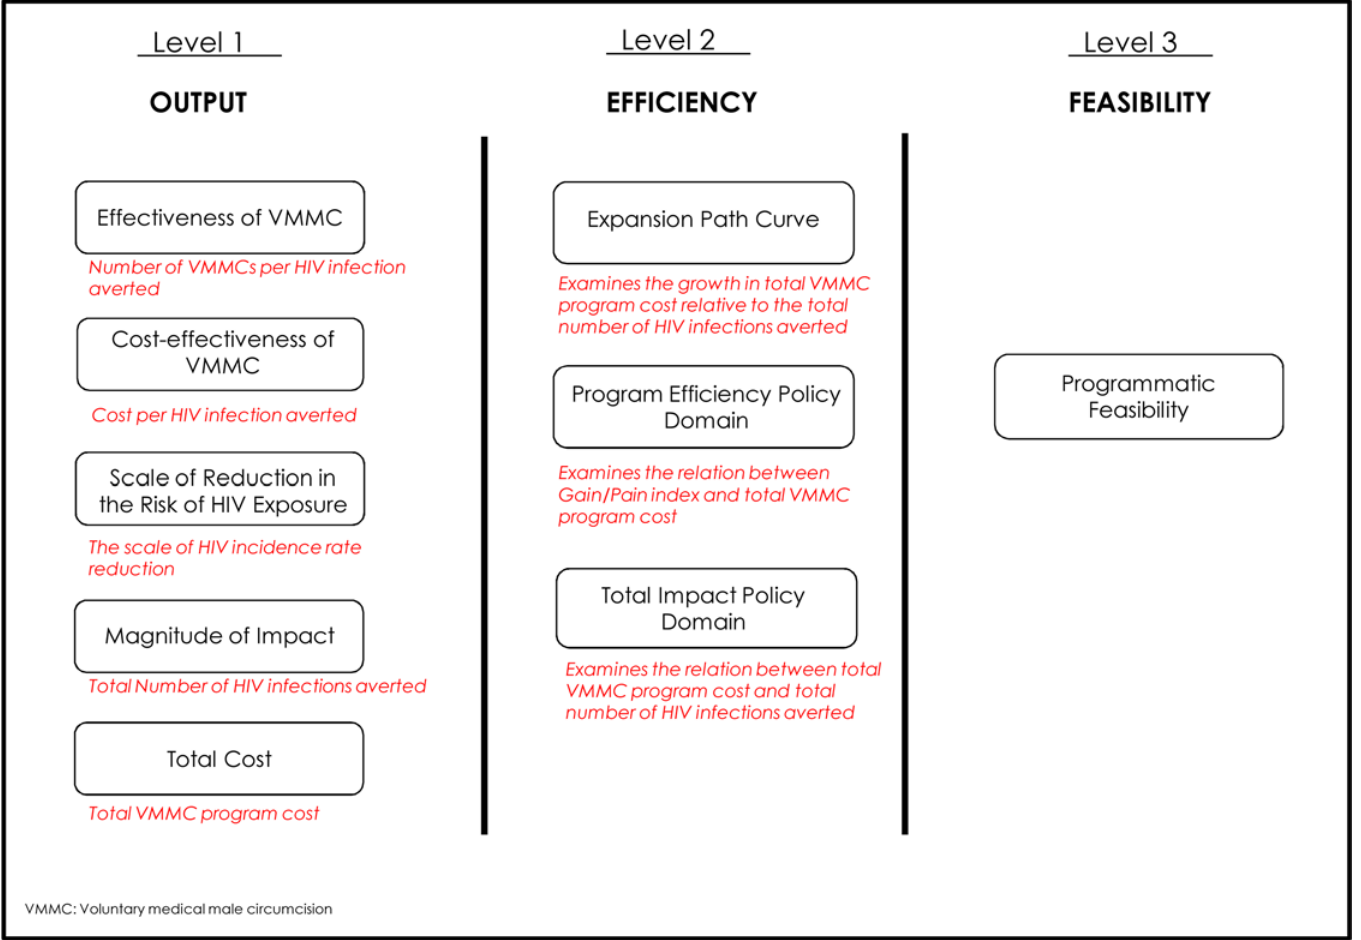
Fig 1. The three-level conceptual framework. The voluntary medical male circumcision (VMMC) program scenarios are assessed based on epidemiologic and health economics measures (Level 1), program efficiency and policy outcome measures (Level 2), and program feasibility (Level 3).